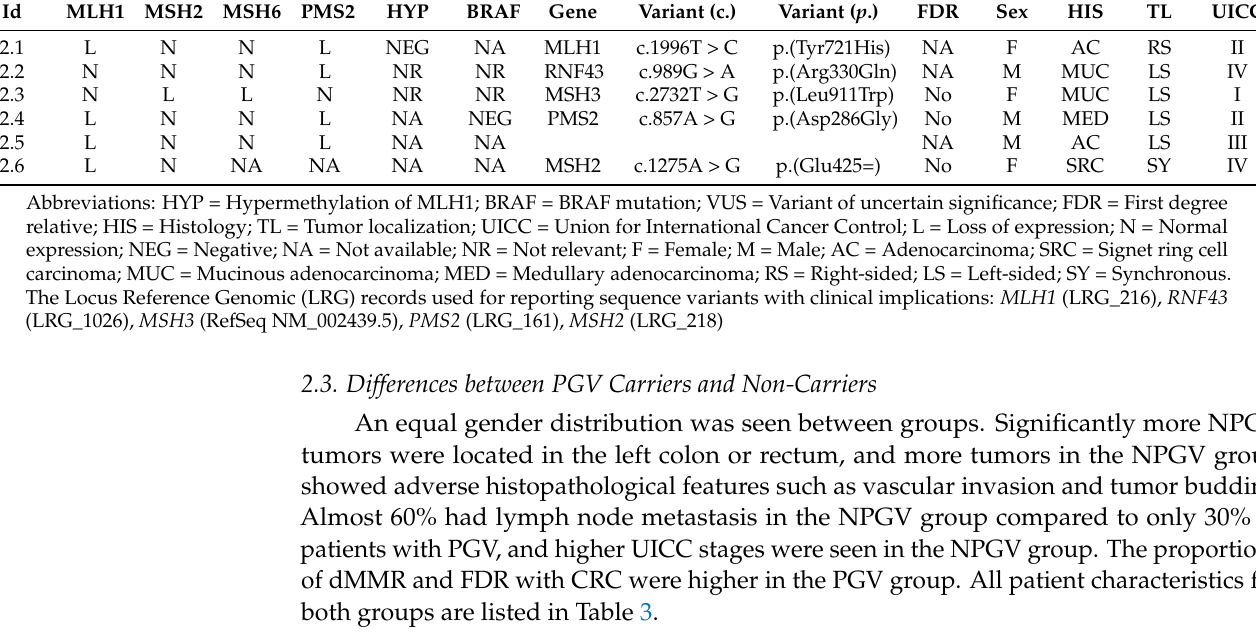
Table 3. Comparision between patients and tumor characteristics in young colorectal cancer patients with pathogenic germline variants (PGV) and no pathogenic variant (NPGV). Significant differences are highlighted with bold text. Patient